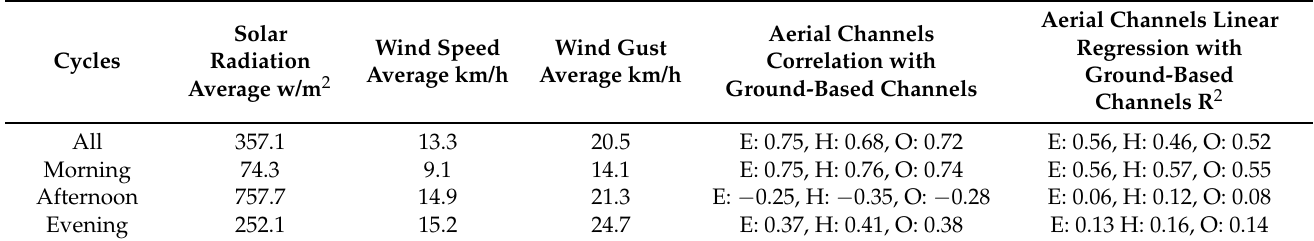
Table 8. Aerial and ground-based spectrometer data comparison. based on different time cycles and observation context